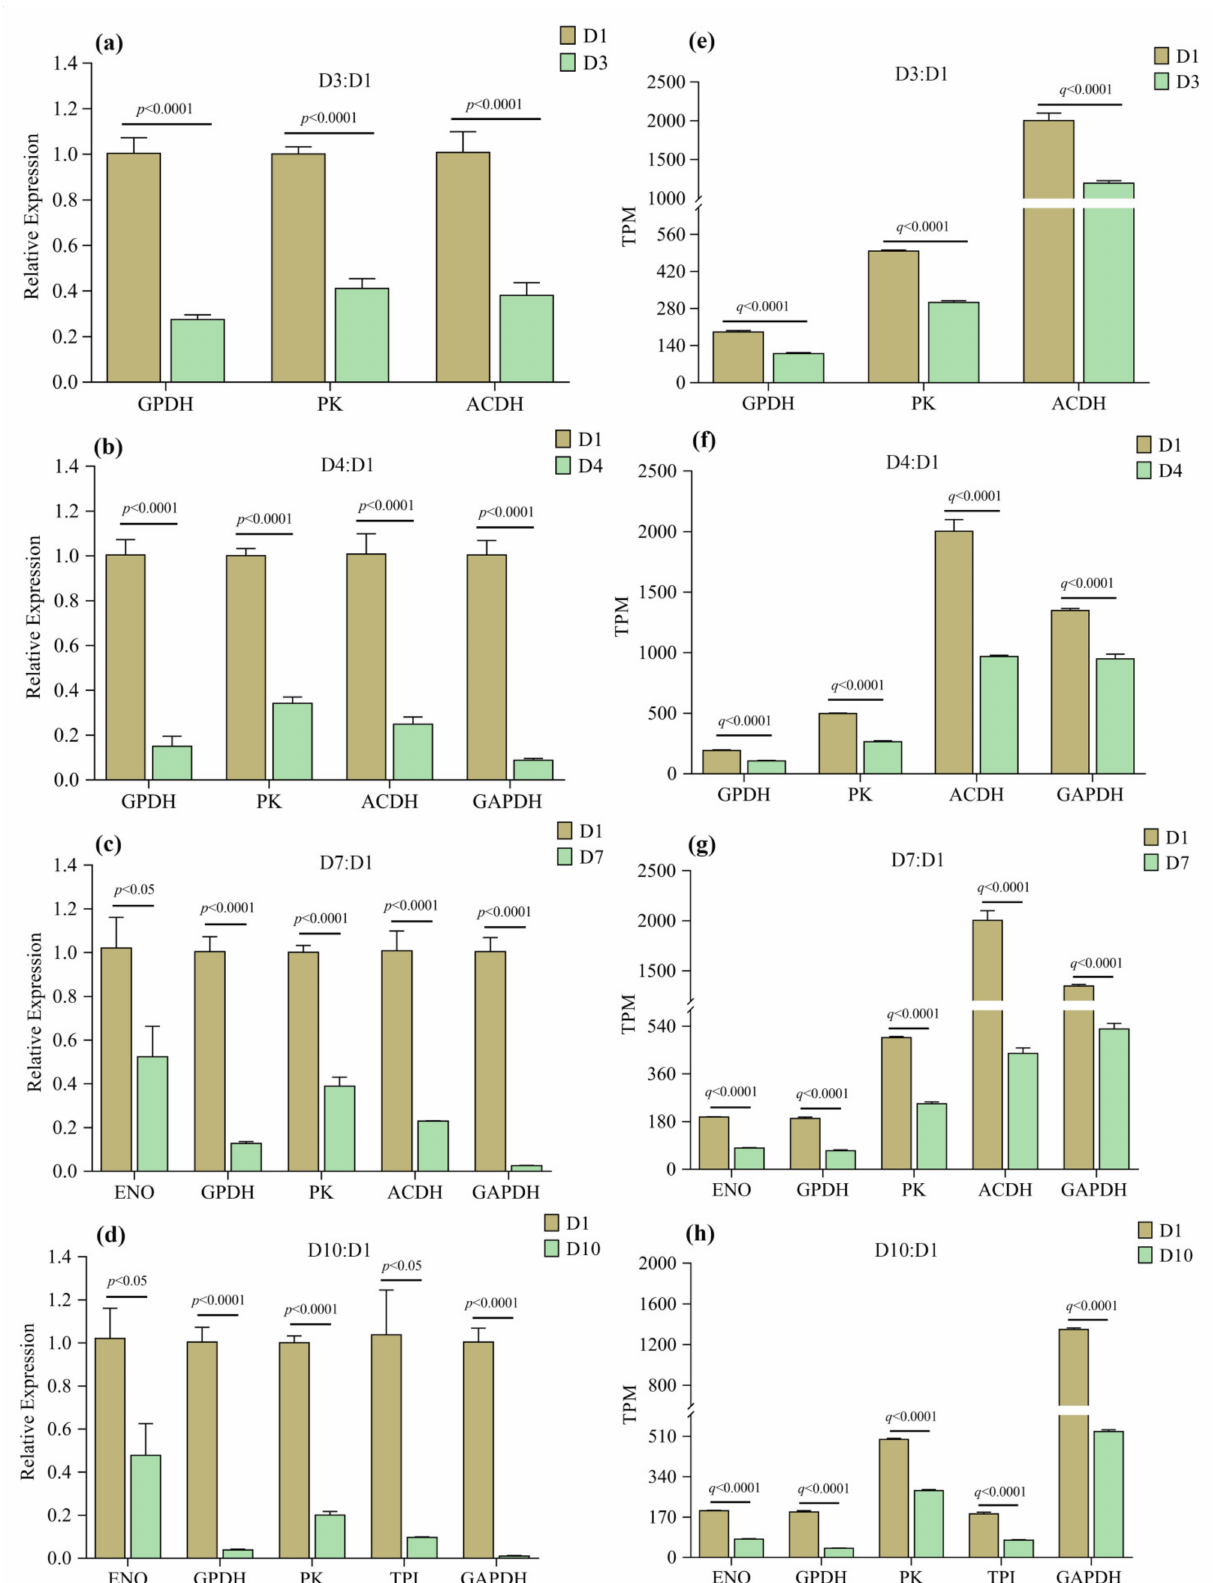
Figure 10. Transcriptome validation for DEGs by qPCR. ( a – d ) are relative expression levels of target genes measured by qPCR, and ( e – h ) are their expression levels measured by RNAseq. Error bars were standard error